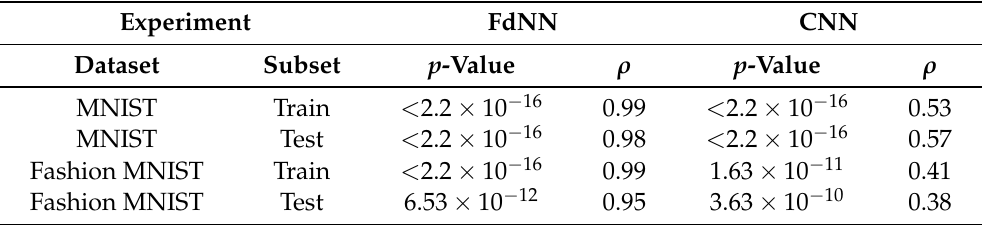
Table 2. Spearman’s correlation test between number of hidden units and categorical accuracy for each simulation